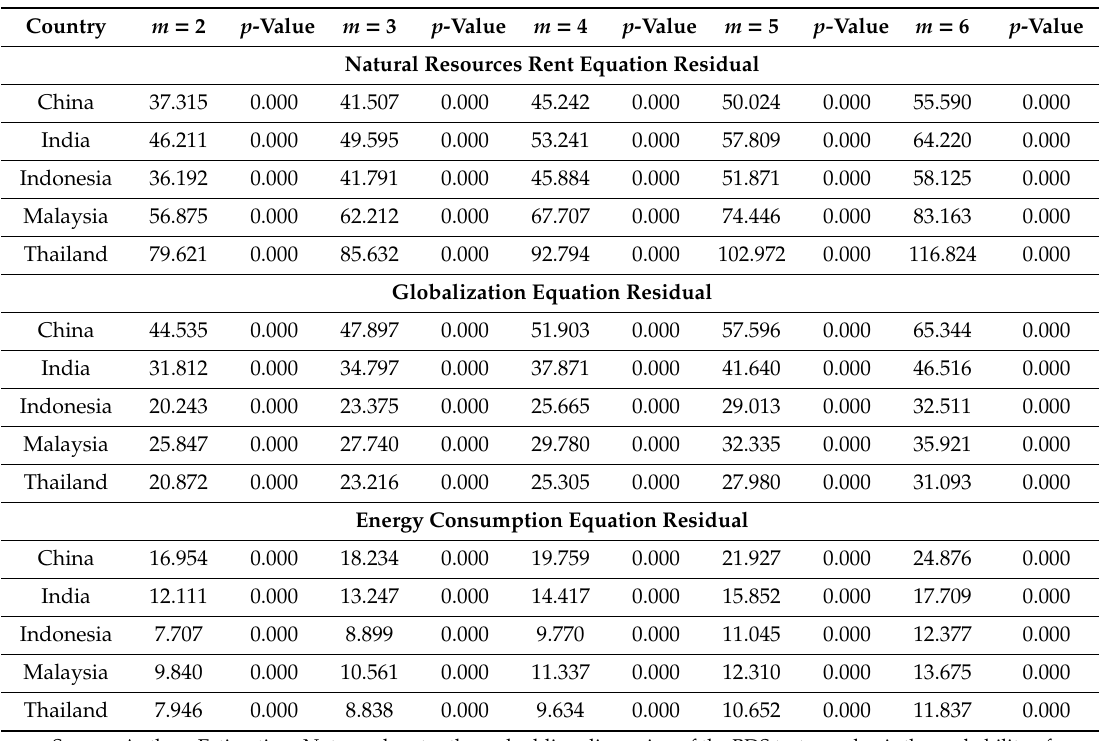
Table 2. Results of BDS test for